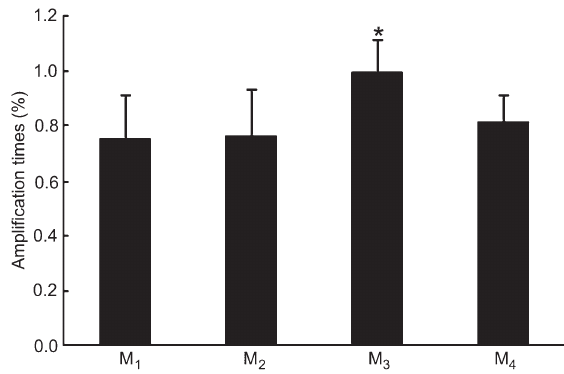
Figure 1. Expressions of different types of muscarinic receptors in human pulmonary microvascular endothelial cells (n=5). M 3 receptor had the highest expression among the four subtypes (M 1 -M 4 ). Therefore, we tested M 3 receptor expression in the subsequent experiment. *P , 0.05, compared with M 1 , M 2 , and M 4 receptors (ANOVA).